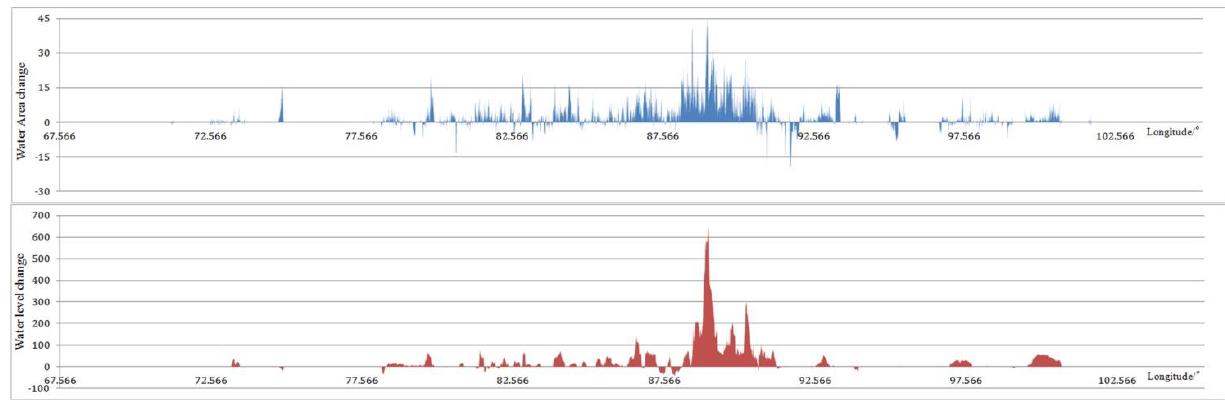
Figure 4. Statistical histogram of lake area and water level change from 2002 to 2012 on TP in